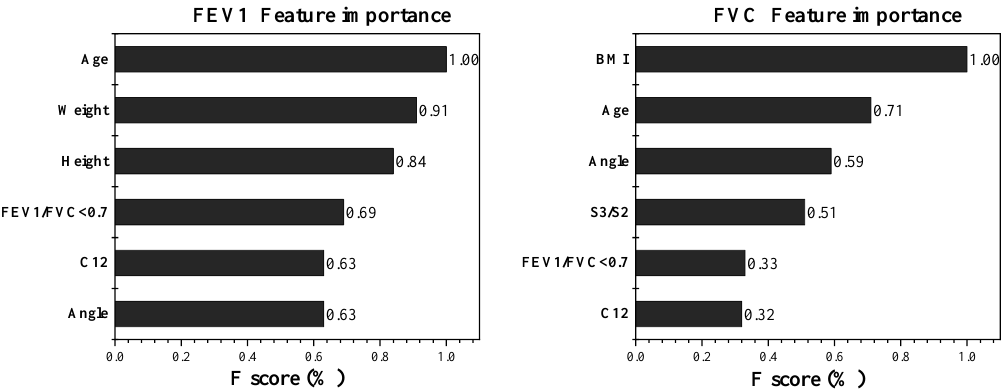
Figure 6. The features ’ importance in conventional machine learning algorithms. The fitting curves and error percentages of conventional machine learning algo- rithms are shown in Figures 7 and 8. Figure 8 shows that the average error of FEV1 pre- diction is 15.71%, and the average error of FVC is only 12.26%. Additionally, the median error for both is less than their mean error, indicating that the pulmonary function predic- tion results are acceptable for most testers. However, we also see that there are individual outliers in the results predicted by FVC, which indicates that the performance of FVC prediction is poor for a small number of results and there is still room for optimization.